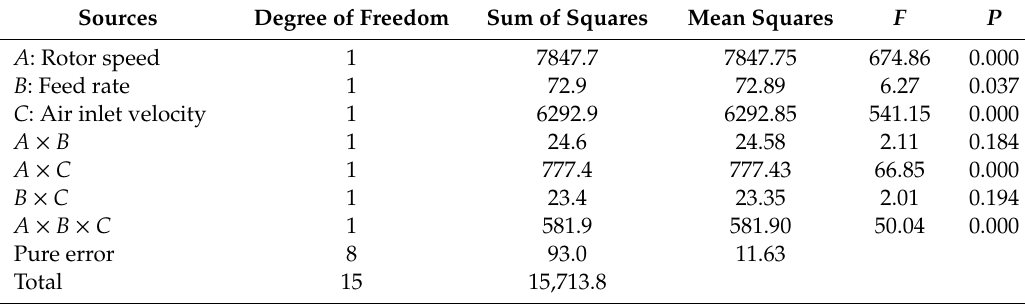
Table 3. ANOVA for the cut size ( d 50